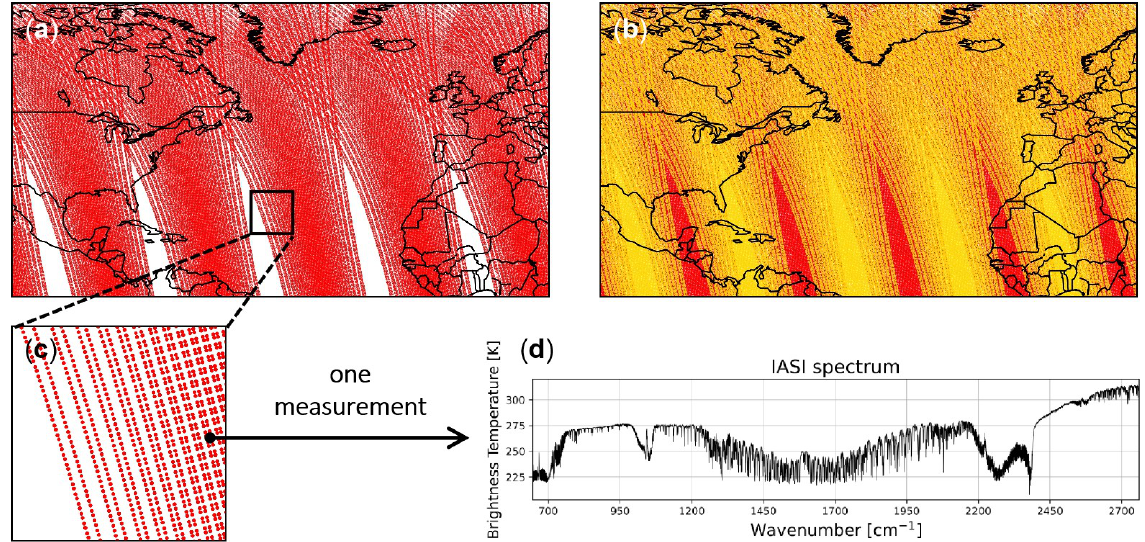
Figure 1. ( a ) IASI observation points for Metop A in the North Atlantic Basin ([5° 75° N], [ − 110° 18° E]) for half a day. In white are the gaps between two orbits. The black square is the area zoomed in panel c. ( b ) Traces for both Metop A (in red) and Metop B (in yellow) on top. The addition of Metop B enabled the coverage of the gaps. ( c ) Observation points of a sample region. ( d ) One IASI observation point, which is a spectrum, in brightness